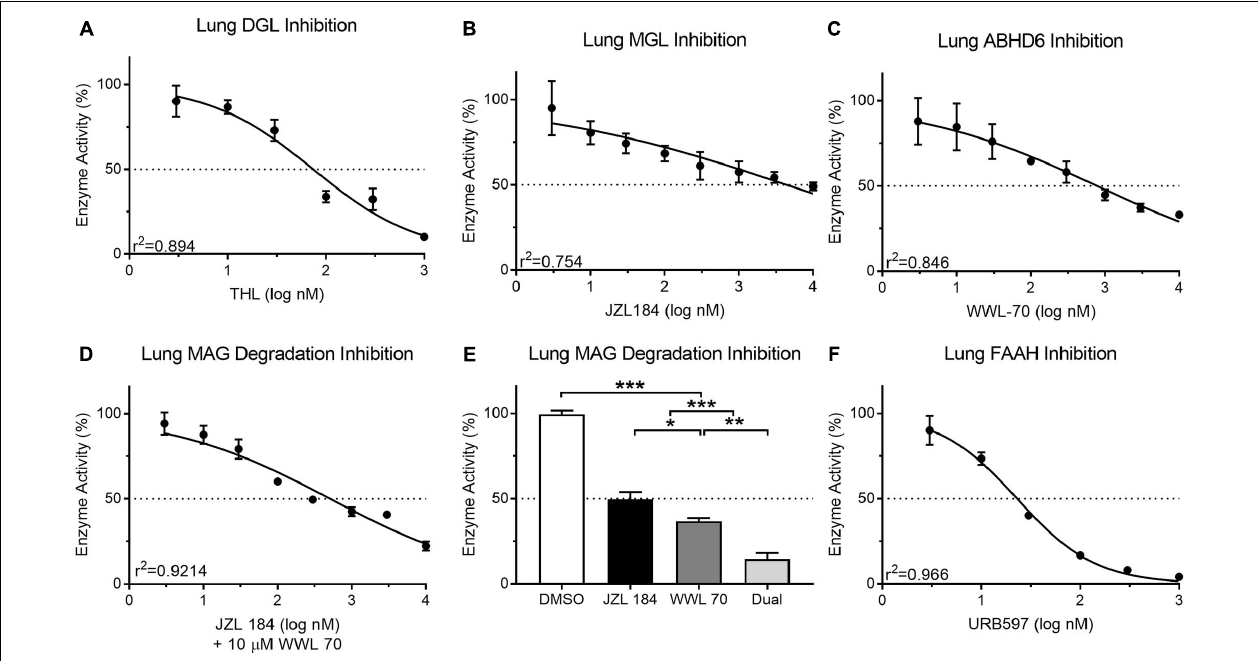
FIGURE 5 | Activity of the MAG biosynthetic enzyme, DGL, in mouse lung protein isolates was dose-dependently inhibited by the DGL inhibitor, THL (A) IC 50 = 74.64 nM. In contrast to small-intestinal epithelium, activity of the MAG degradative enzyme, MGL, in mouse lung was not effectively reduced past 50% with concentrations up to nearly 10 µ M of the MGL inhibitor, JZL 184 (B) IC 50 = 4,394 nM. Activity of the MAG degradative enzyme, ABHD6, in mouse lung was inhibited by the ABHD6 inhibitor, WWL 70 (C) IC 50 = 779.9 nM. Dose-dependent inhibition of MAG metabolism in mouse lung tissue was achieved when all samples were also incubated with 10 µ M WWL 70 (D) IC 50 = 510.14 nM. When mouse lung was incubated together at 10 × the respective IC 50 for each MAG degradation inhibitor (JZL 184 = 43,940 nM; WWL 70 = 7,799 nM), MAG degradative enzyme activity was reduced to 14.62% (E) . Activity of the FAE degradative enzyme, FAAH, in mouse lung protein isolates was inhibited by the FAAH inhibitor, URB597 (F) IC 50 = 22.95